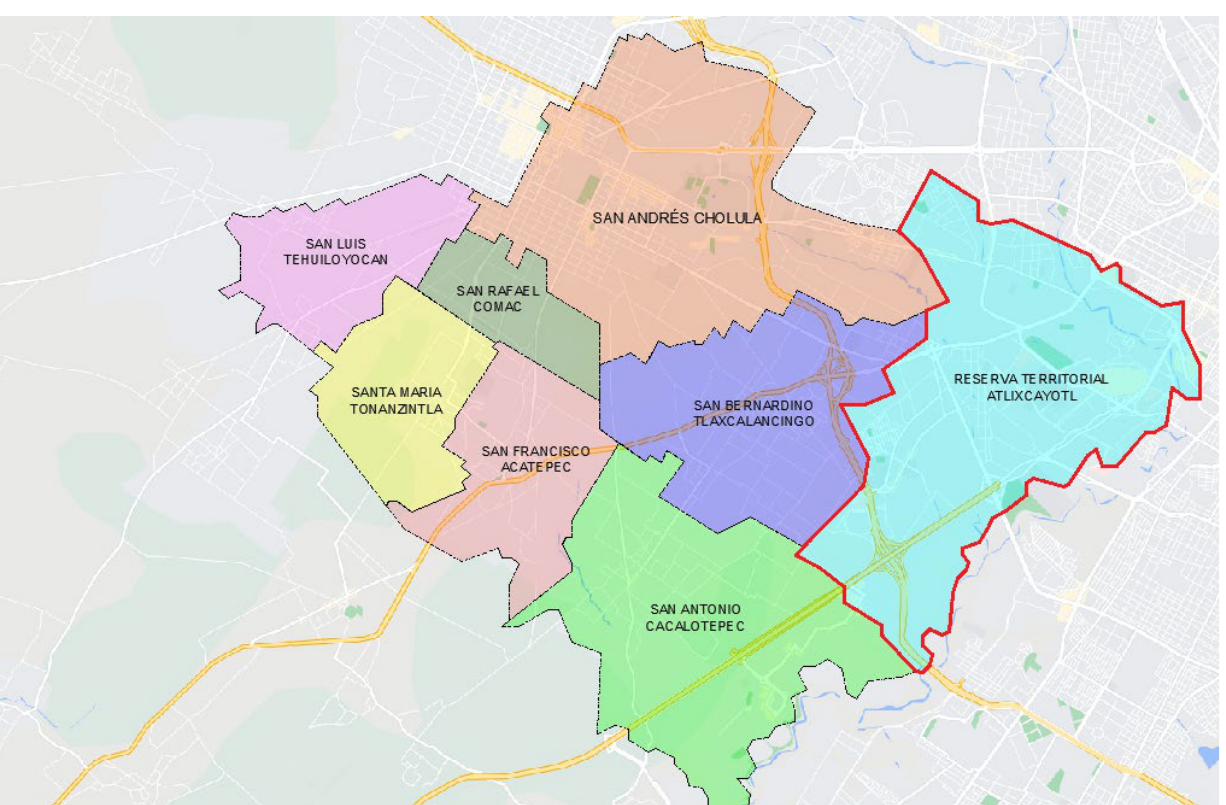
Figure 2. Schematic approach to the territory. San Andrés Cholula ( cabecera municipal ) and its seven auxiliary boards ( juntas auxiliares) . Most of the study area is comprised of Reserva territorial Atlixcáyotl (in red), San Bernardino Tlaxcalancingo and San Antonio Cacalotepec. Elaborated by Eduardo Gutiérrez. (2022).